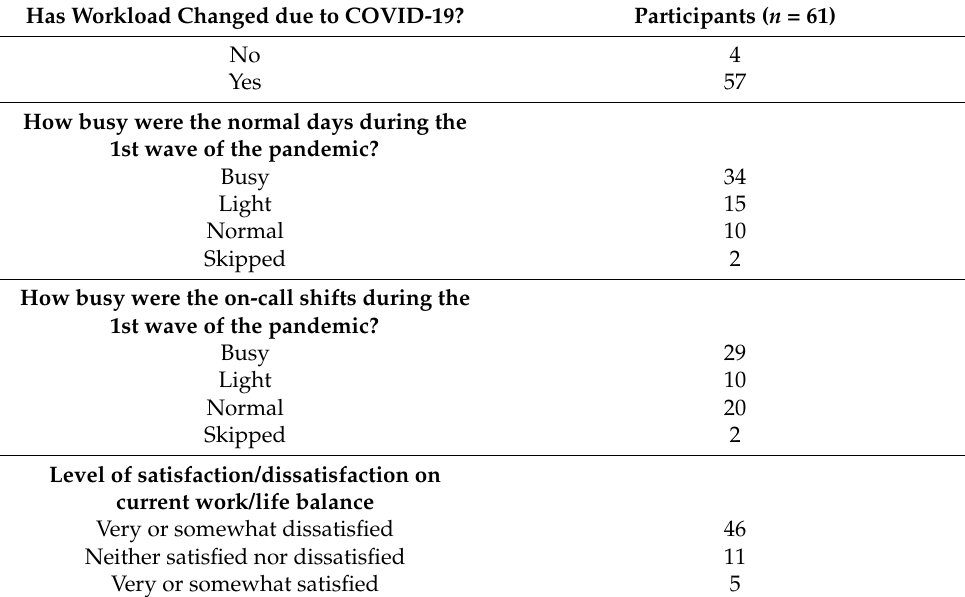
Table 2. Workload and work-life changes due to